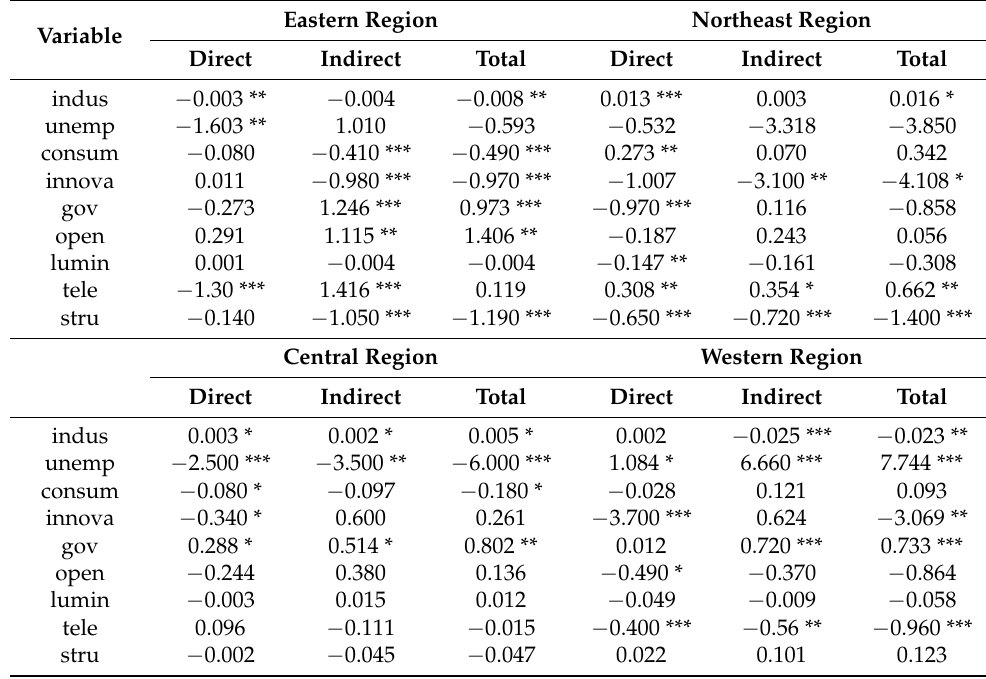
Table 5. Direct effect, spatial spillover effect, and the total effect of the SDM model by region. Eastern Region Northeast Region Variable Direct